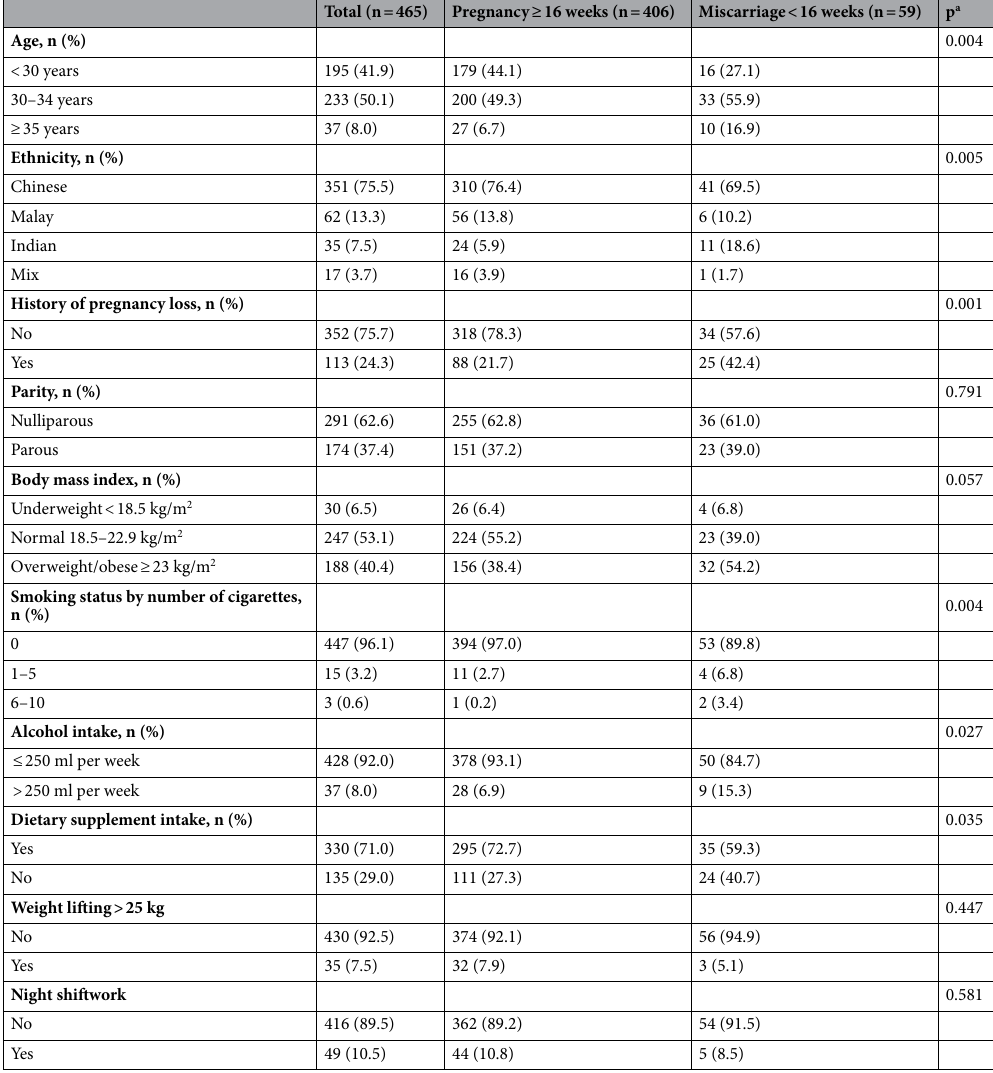
Table 1. Comparison of baseline characteristics between women with miscarriages < 16 weeks gestation and with pregnancy ≥ 16 weeks, from the S-PRESTO study (n = 465). S-PRESTO Singapore PREconception Study of long-Term maternal and child Outcomes. a Based on Pearson’s chi-squared